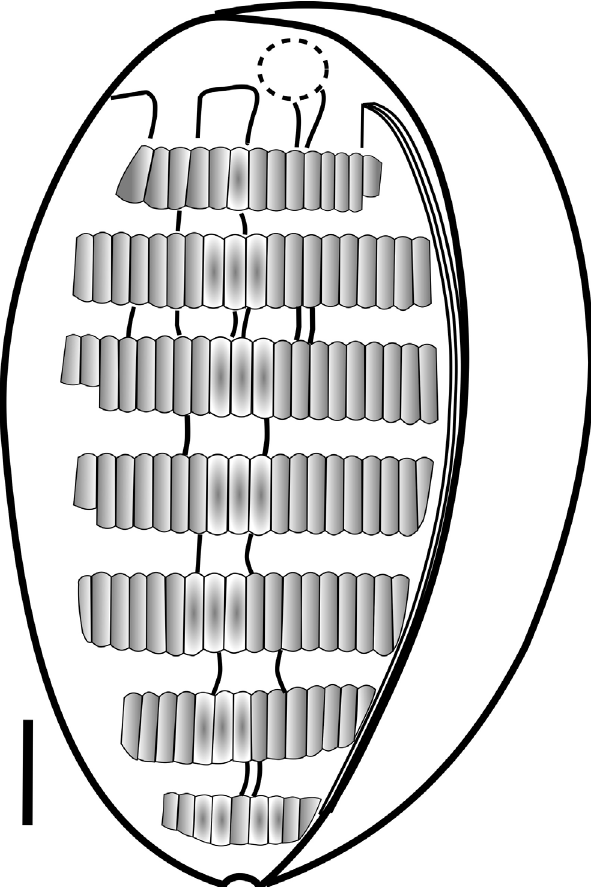
Fig 7 . Mature nest of Chartergellus trinitatis in partial cut- away view. Scale bar = 2.0